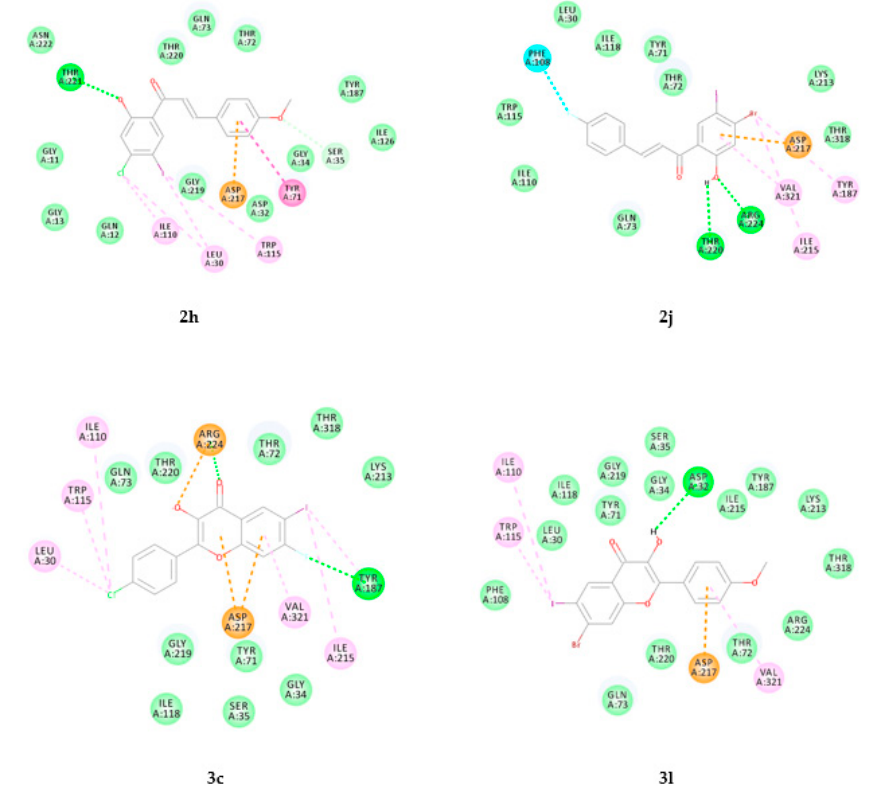
Figure 9. Docking poses of 2h , 2j , 3c and 3l into BACE-1. Interactions are color coded, bright green represents conventional hydrogen bonds, light green- van der Waals interactions, very light green- carbon hydrogen bonds, orange- pi-anion and attractive charge interactions, blue- halogen bonds, dark pink- pi–pi interactions and light pink- pi–alkyl and alkyl interactions.